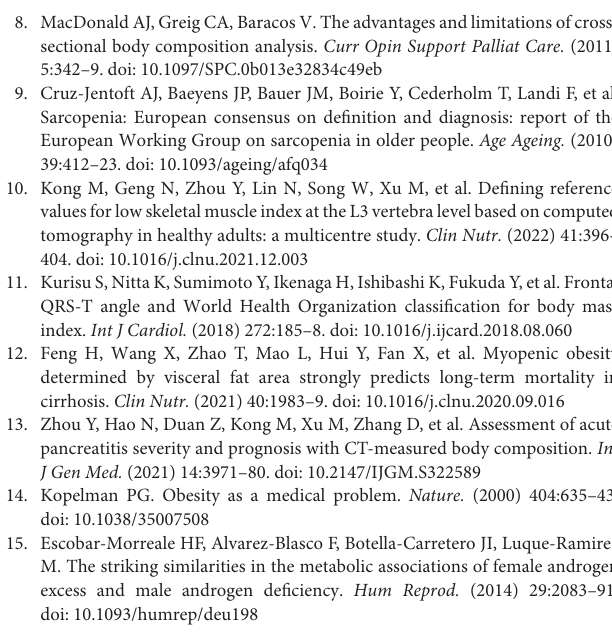
Supplementary Figure 1 | Four representative cities in northern China. Supplementary Table 1 | CT units used and detailed technical parameters. Supplementary Table 2 | Distribution of body composition by sex and